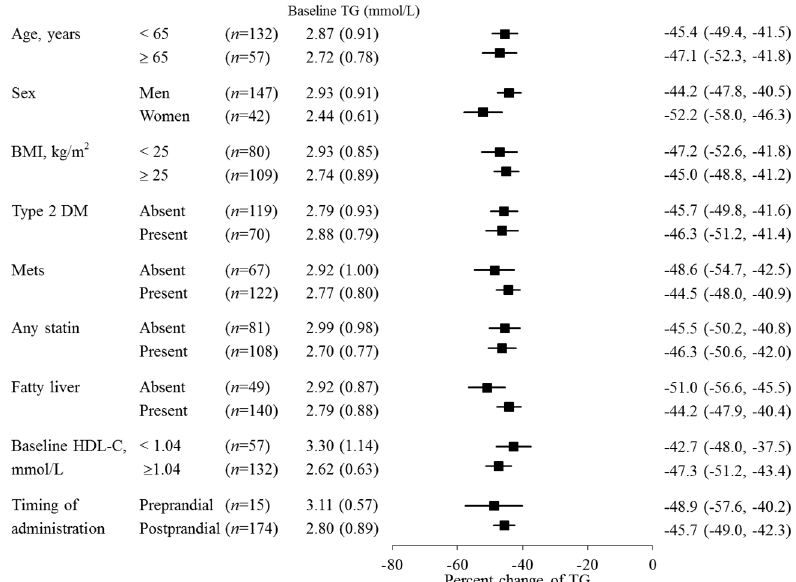
Figure 2. Time course of fasting serum TG levels. Data are presented as means ± SD. TG, triglyceride; LOCF, last-observation-carried-forward; SD, standard deviation.